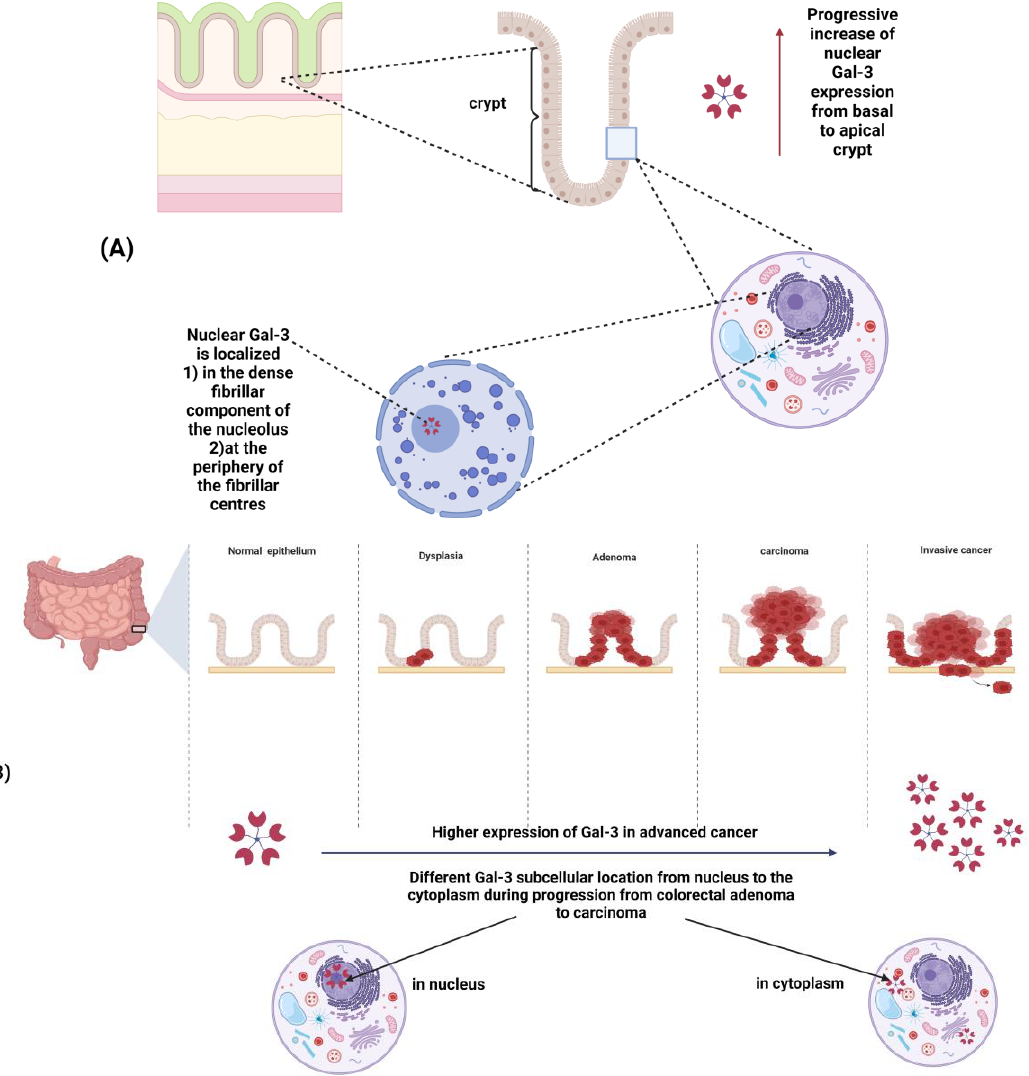
Figure 2. ( A ) Galectin-3 expression in normal colonic mucosa: a progressive increase in Gal-3 expression occurs from the basal to the apical side of the crypt; within the nucleus, Gal-3 is localized in the dense fibrillar components of the nucleolus as well as in the periphery of the fibrillar centers.( B ) Changes in Gal-3 expression and/or subcellular localization during colorectal cancer progression: Gal-3 expression is increased in advanced cancer. A different subcellular localization (from the nucleus to the cytoplasm) is observed during progression from colorectal adenoma to carcinoma. Accordingly, serum levels of Gal-3 are significantly elevated in both ulcerative colitis (UC) and Crohn’s disease ( CD) patients compared to healthy people [44,45]. Furthermore, enhanced Gal-3 concentration in serum and stool samples of patients with UC correlates with clinically and histologically severe disease [46], thus, representing a valuable bi- omarker for monitoring UC progression. The results achieved in UC patients are in keep- ing with data obtained in a murine model of dextran sodium sulphate (DSS)-induced co- litis, where Gal-3 expression promotes acute colitis and plays an important pro-inflamma- tory role in the colonic epithelium [47]. However, the potential use of serum Gal-3 levels as an IBD biomarker is still controversial since recent studies failed to show increased serum levels of Gal-3 in UC and CD patients [48]. Differences in factors that affect the levels of Gal-3, such as age, renal function and co-morbidities, as well as the stage of the disease, could explain the discrepancies observed within IBD studies. Moreover, higher serum and fecal content of Gal-3 was observed in subjects with UC and metabolic syn- drome, showing clinically and histologically milder disease compared to subjects suffer- ing from UC only [49], indicating that Gal-3 may also be involved in the mechanism lim- iting the inflammatory process in UC. Notably, IBD is associated with an increased risk of CRC that appears to raise with the duration, severity and extent of colonic inflammation [50]. Increased Gal-3 expression has been amply recognized in colon carcinogenesis [38,51,52] and is considered a prognostic factor of poor outcome [44]. An interesting study by Tao and colleagues, examining Gal-3 expression in CRC cases in both cancer tissue and adjacent normal tissue via immunohistochemistry, revealed an association between Gal- 3 levels and the clinical/pathological characteristics of disease [38]. However, conflicting results emerged on the relationship between the pattern of Gal-3 expression and tumor progression because some studies reported decreased or comparable Gal-3 levels during CRC progression [53 – 59]. A possible explanation for this discrepancy comes from the study of Tsuboi and co-workers, who, focusing on Gal-3 expression changes in two dif- ferent tumor areas, highlighted the presence of a significant number of liver metastases when the expression of Gal-3 was lower at the invasive front of the tumor as compared to its surface [52]. Additionally, emerging evidence reveals that patients with detectable ex- pression of Gal-3 in the tumor have more lymph node and distant metastases, frequent